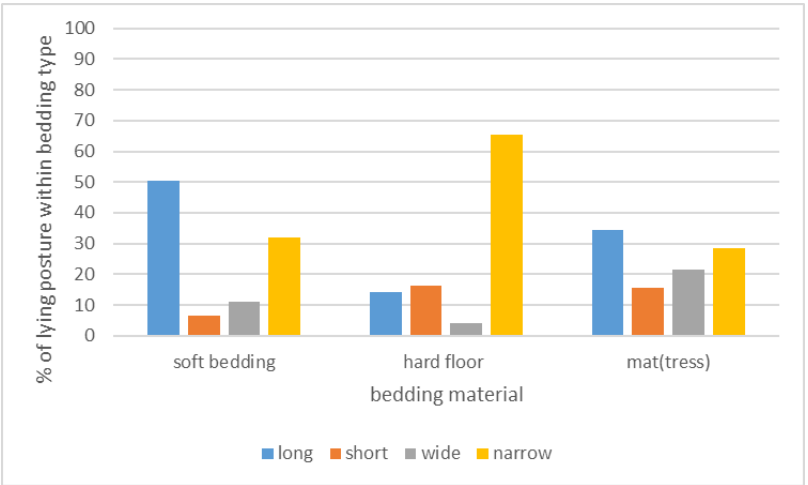
Figure 6. Recorded postures of cows in cubicles with different bedding materials. Results from 527 pictures of lying cows on 25 Dutch farms.